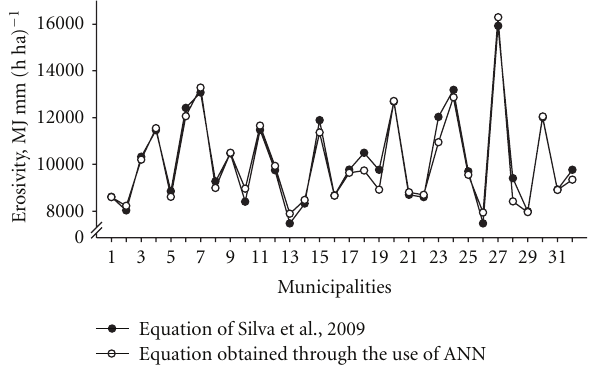
Figure 2: Erosivity values estimated by Silva et al. [8] and by the ANN for each municipality.